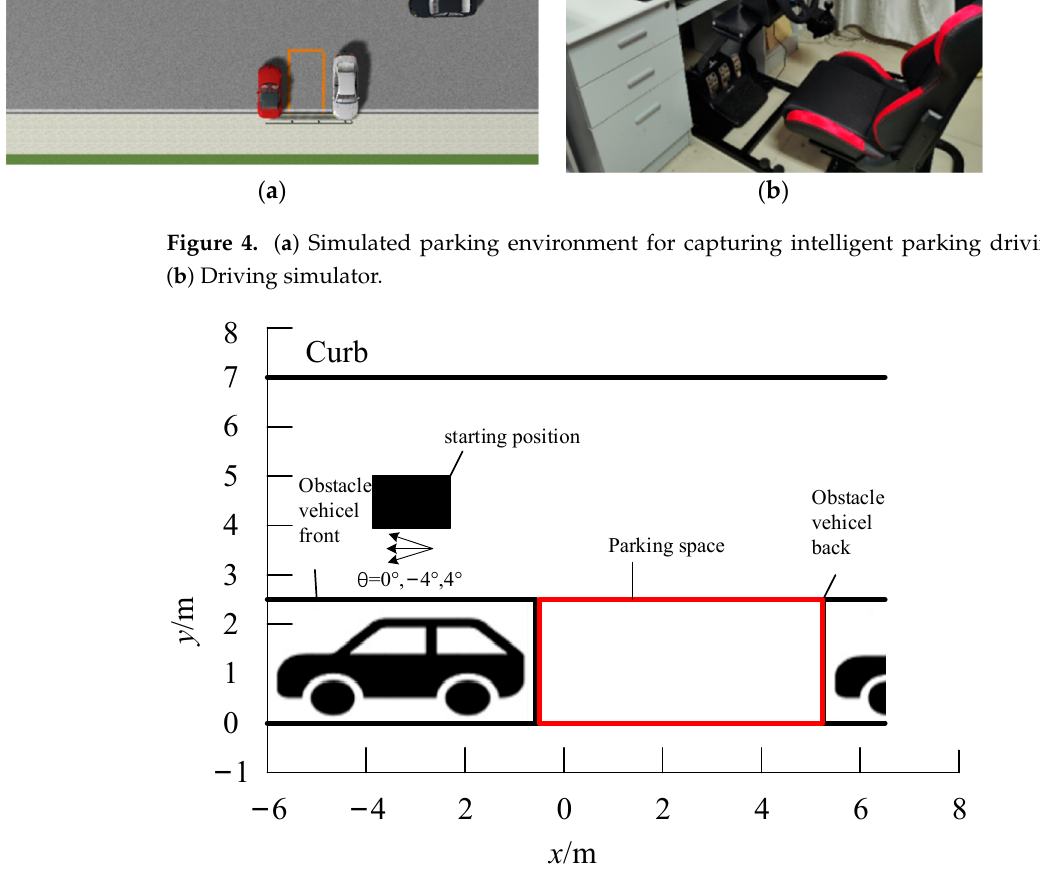
Figure 5. Starting area in the simulated parallel parking slot.